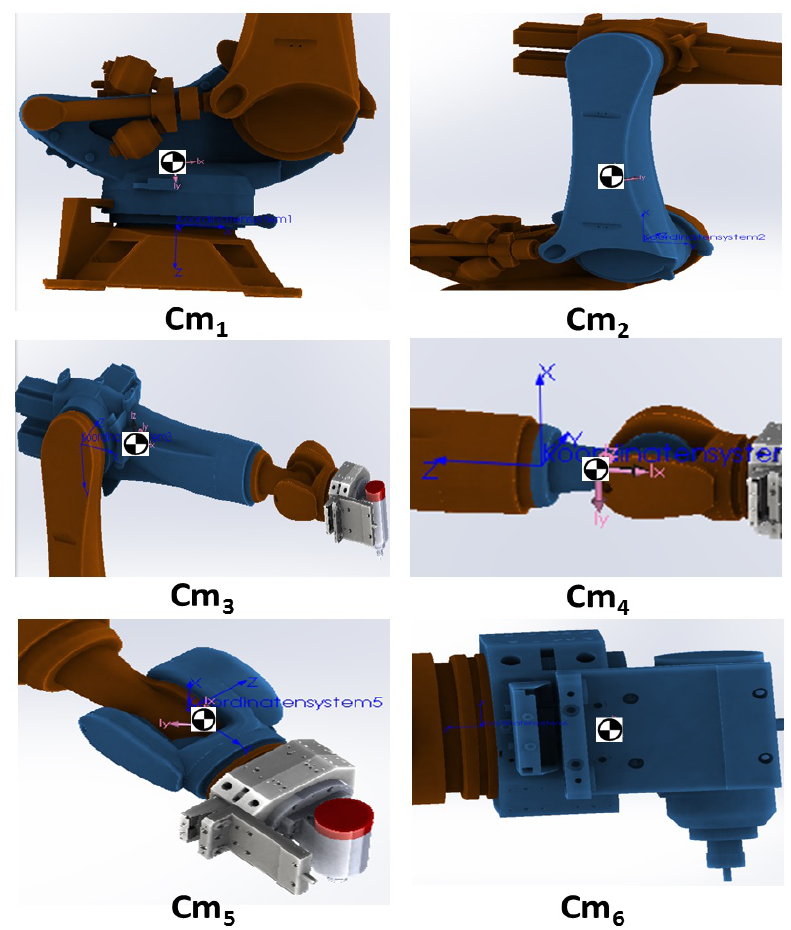
Figure A1. Illustration of the center of mass for each joint of the KUKA